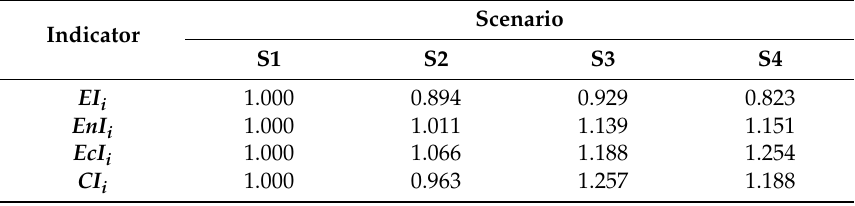
Table 9. Normalized Indicators and combined results for scenarios